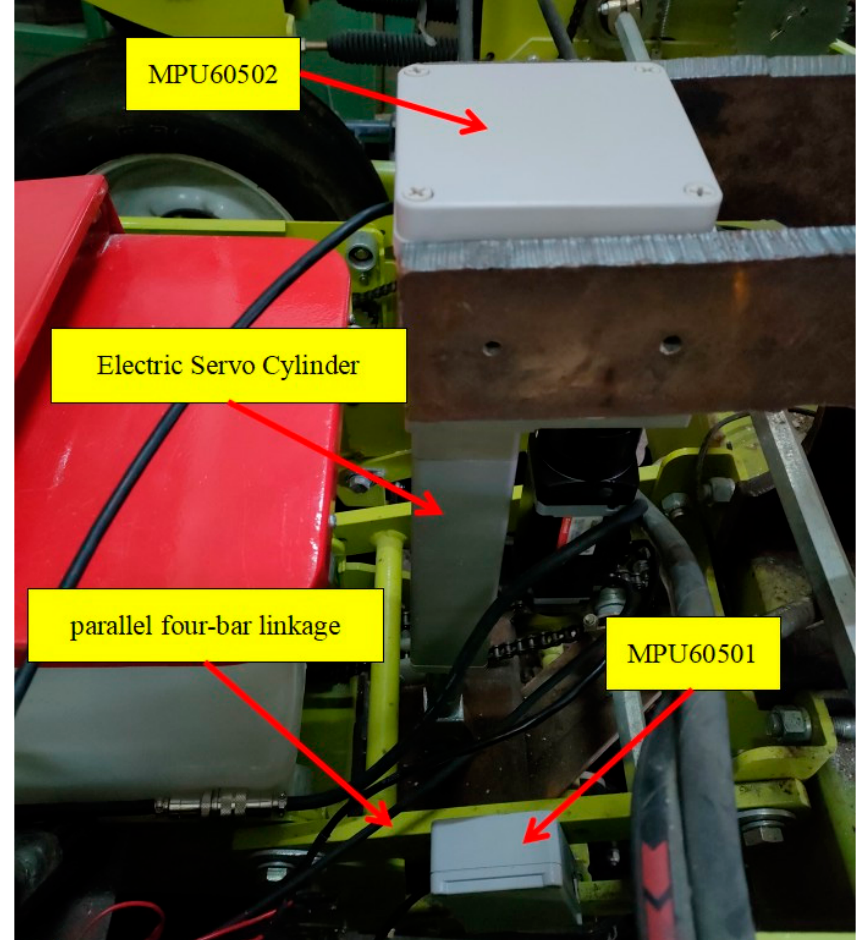
Figure 13. Sowing monomer testing site.